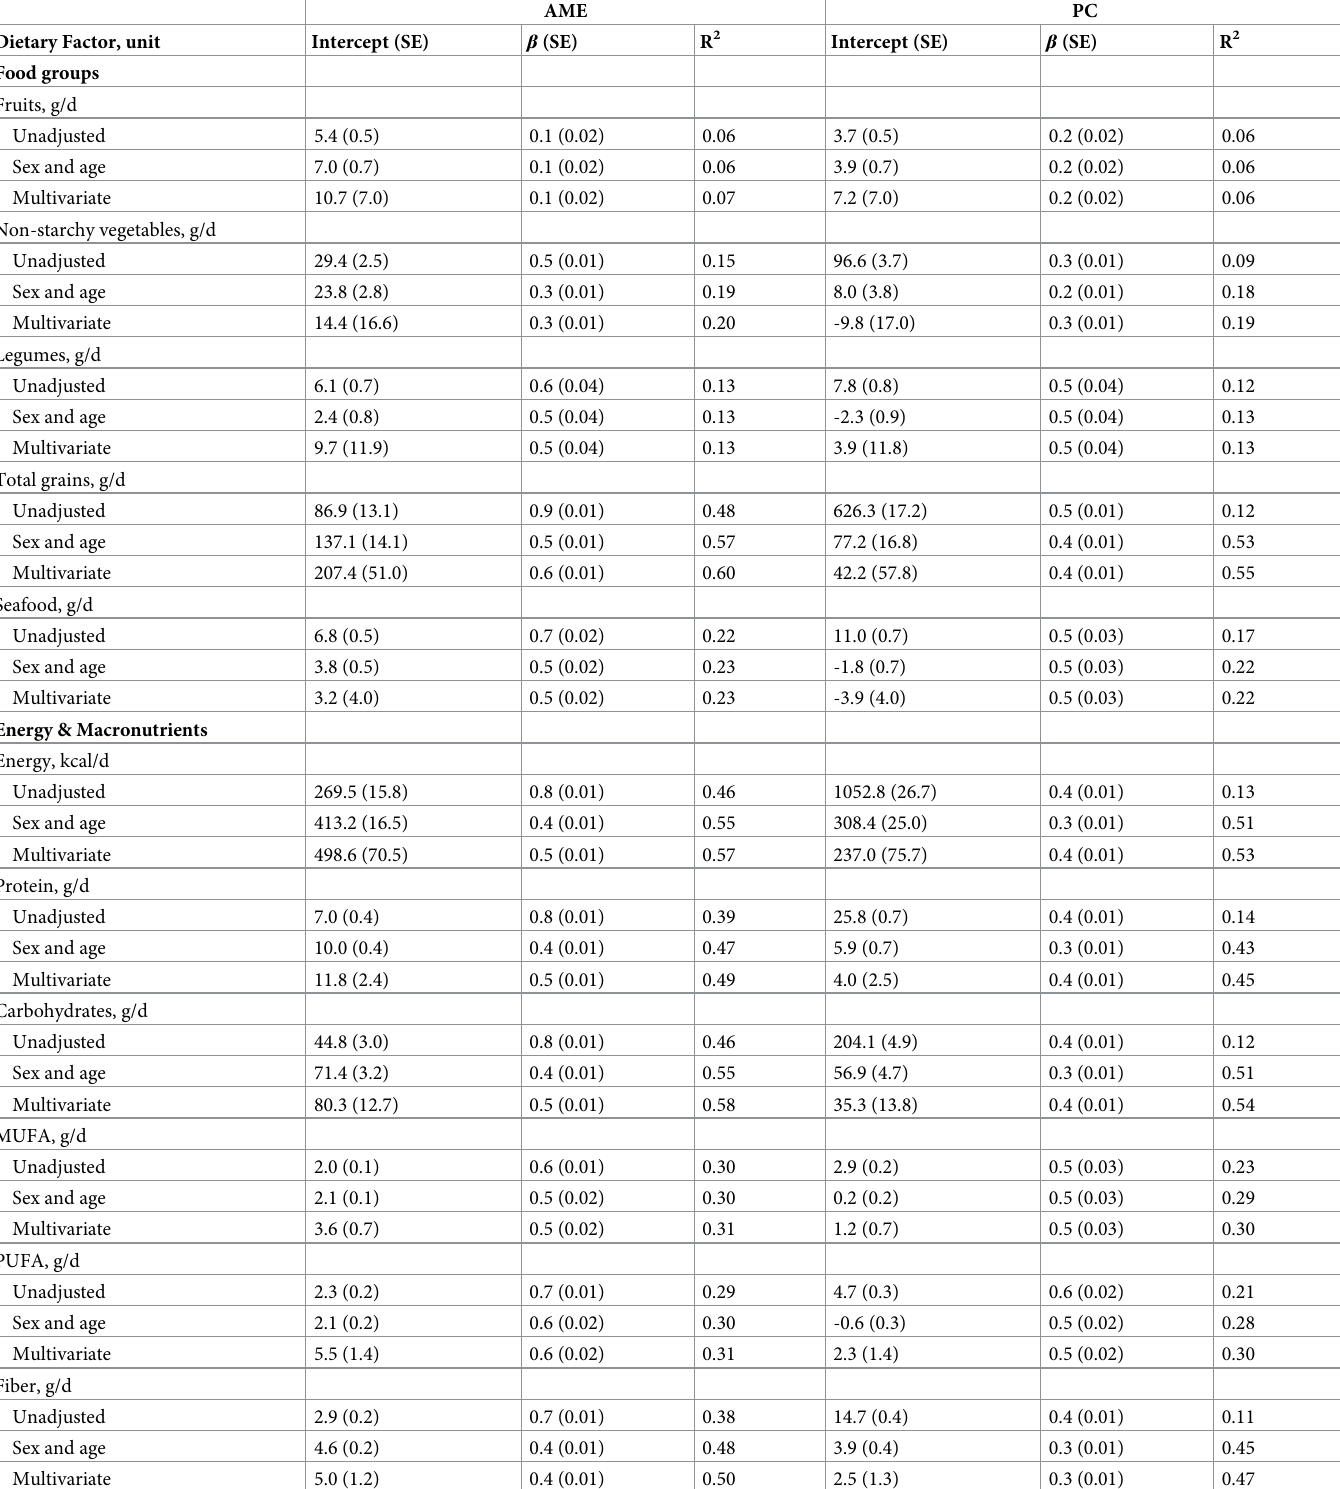
Table 3. Relation between individualized household intake estimates as predictors of individual dietary intakes in the 2011–2012 BIHS 1 . AME PC Dietary Factor,